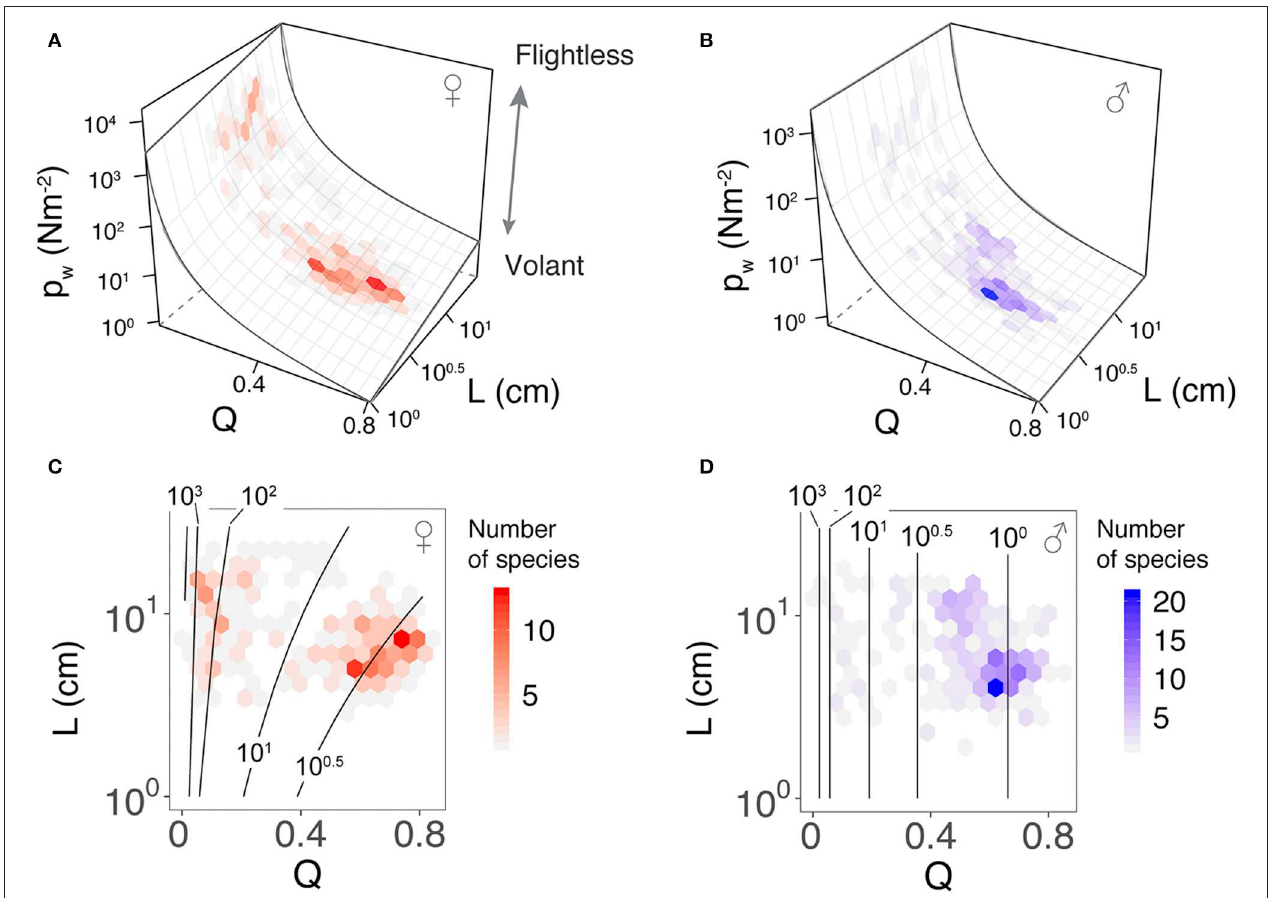
FIGURE 5 | Sex-specific landscapes of wing loading relative to dimorphism and body length among phasmid species. (A,B) , wing loading relationships for females and males, respectively, between the two sexes; females typically have higher wing loading than males and stronger allometric effects relative to body length. (C,D) , contours of the wing loading landscape for females and males, respectively, as overlaid with hexagonal bins for species counts ( Figures 3D,E ); wing loading distribution differs substantially between the